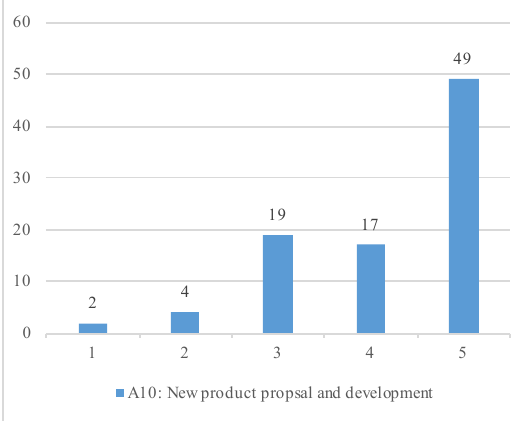
Figure 2. Frequency distribution of